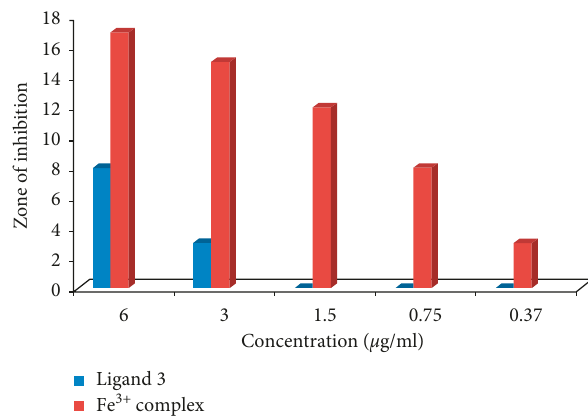
Figure 8: Antimicrobial activity of the derivative (L) and its Fe 3+ complex against E. coli (G ve). −